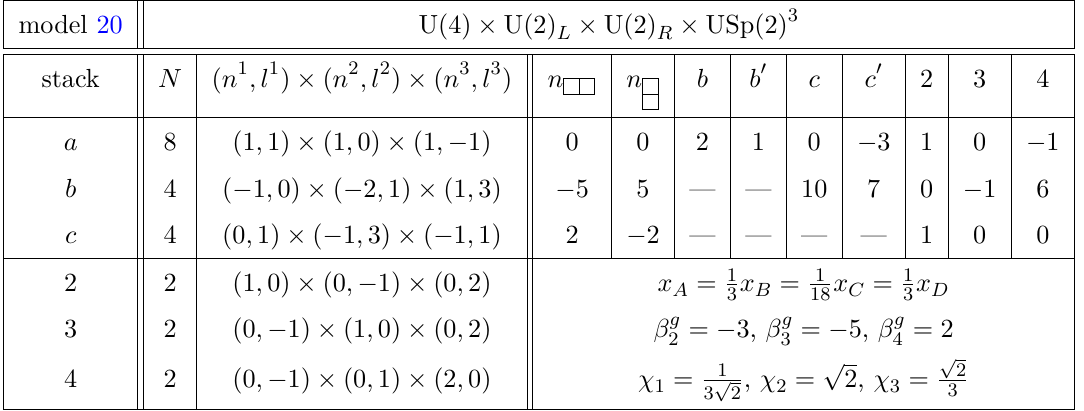
Table 20 . D6-brane configurations and intersection numbers of Model 20, and its MSSM